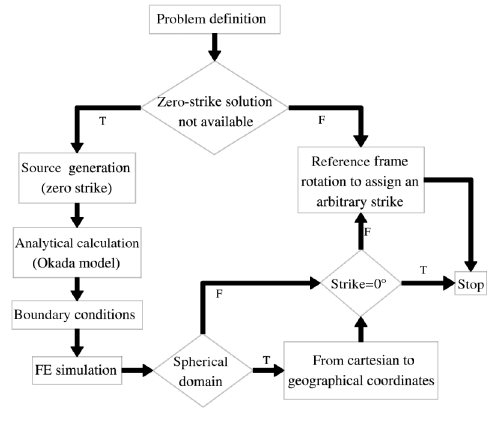
Fig. 2. Block diagram of the automatic procedure to numerically calculate the displacement field in- duced by faulting sources, as described in the